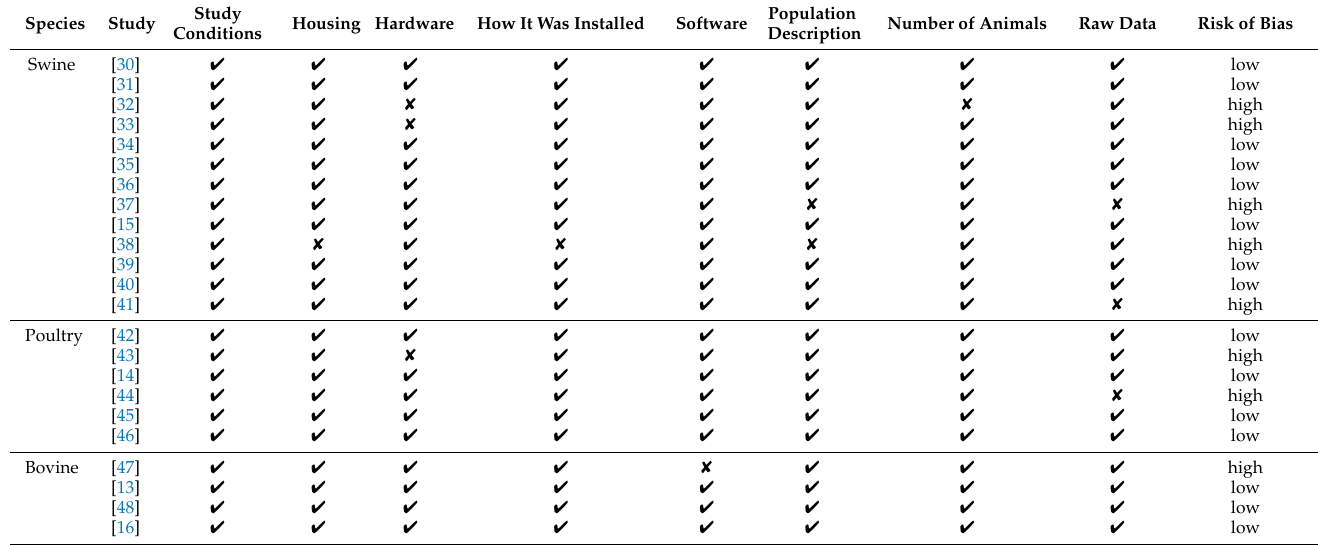
Table 3. Evaluation of the descriptions of eight essential pieces of information in the studies to assess risk of